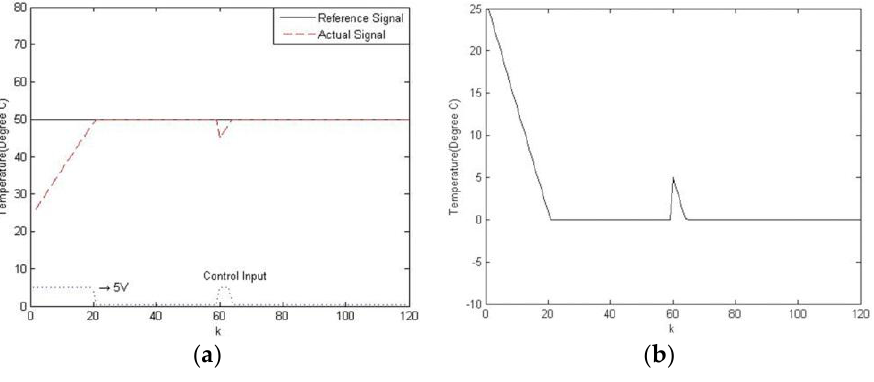
Figure 25. ( a ) Outputs and ( b ) errors of the FNFN controller with impulse noise in the water bath system.